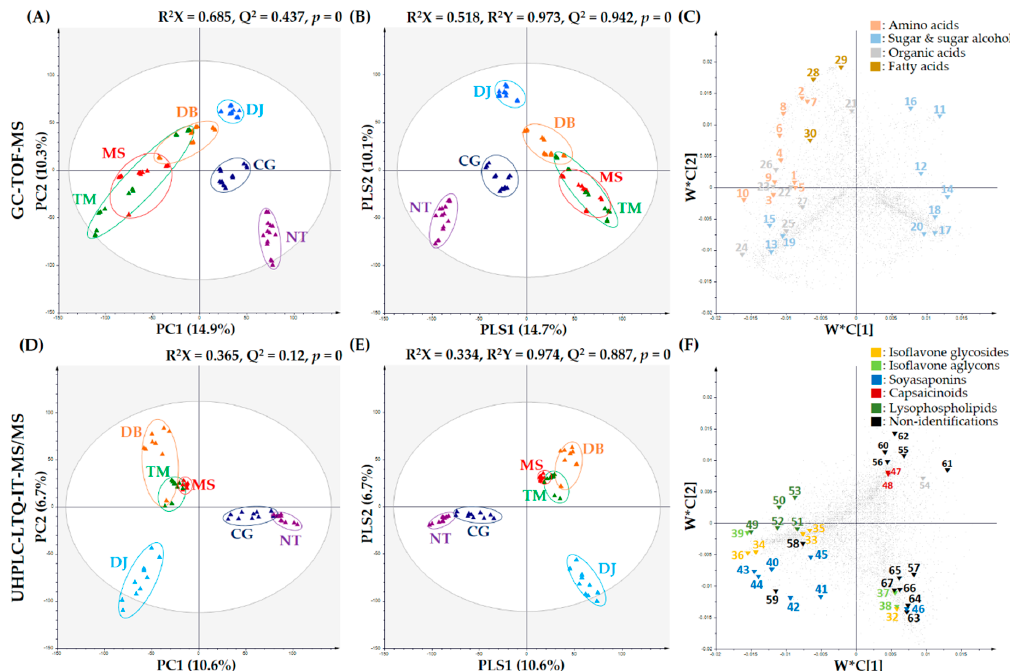
Figure 1. PCA score plots, PLS-DA score plots, and PLS loading plots of six FSPs (NT: natto , CG: cheonggukjang , DJ: doenjang , MS: miso , DB: doubanjiang , TM: tianmianjiang ). ( A ) PCA score plot, ( B ) PLS-DA score plot, and ( C ) PLS-DA loading plot derived from GC-TOF-MS; and ( D ) PCA score plot, ( E ) PLS-DA score plot, and ( F ) PLS-DA loading plot derived from UHPLC-LTQ-IT-MS/MS. Plot